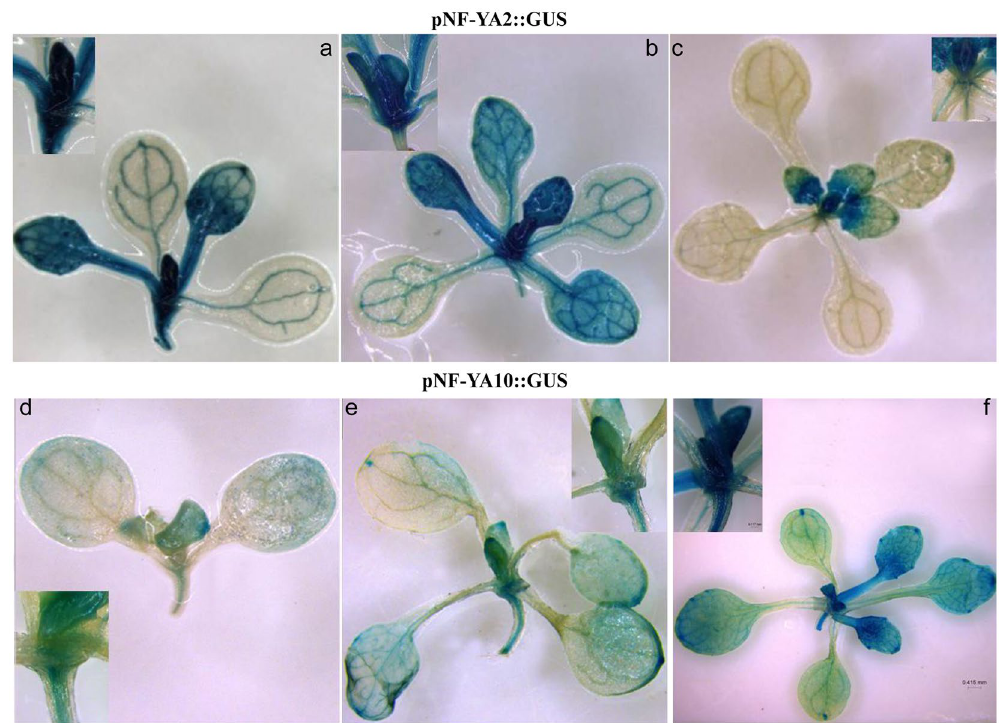
Figure 3. Expression profile of NF-YA2 and NF-YA10 in transgenic plants. ( a – c ) NF-YA2 expression pattern in 10-d-old, 13-d-old, and 16-d-old seedlings; ( d , e ) NF-YA10 expression pattern in 10-d-old, 13-d-old, and 16-d- old seedlings. Plants were grown on MS medium in a standard LD light